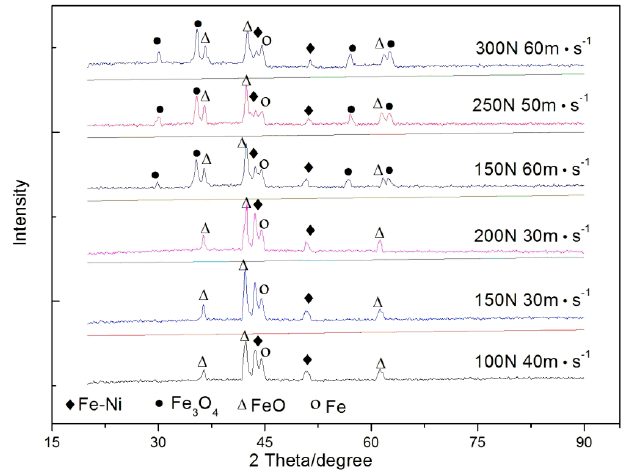
Figure 7. XRD patterns of worn surfaces of 18Ni(300) maraging steel.